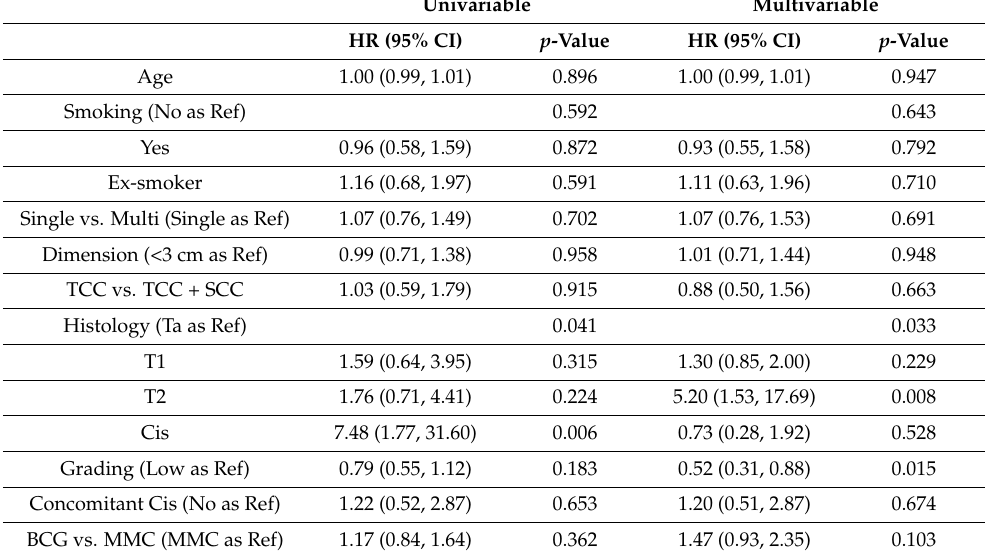
Table 2. Multivariable Cox regression analysis predicting recurrence.